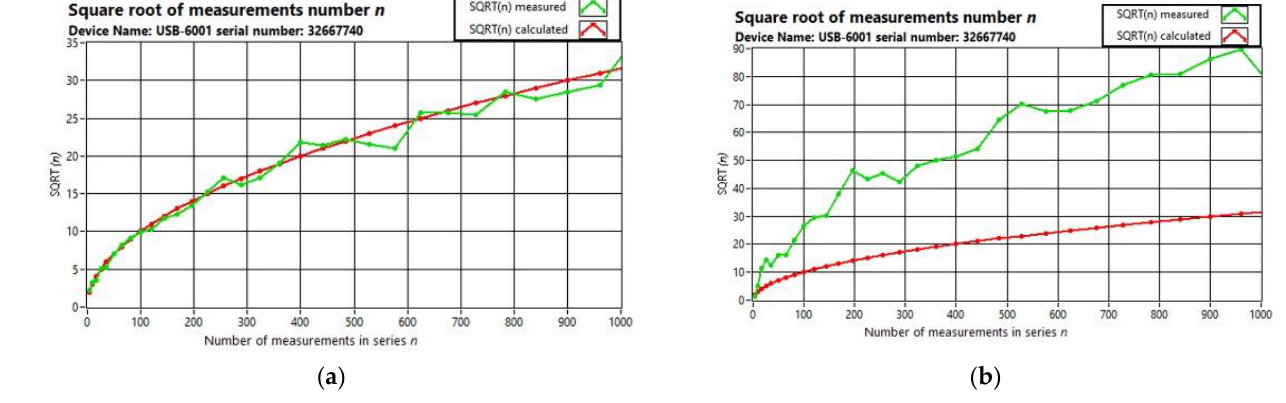
Figure 14. The ratio of the experimental standard deviation in a single result in a series to the experi- mental deviation of the mean value of a series of n measurements compared to the root of the number of measurements for the tested module NI USB-6001: ( a ) at low interference level, ( b ) at high interference level.